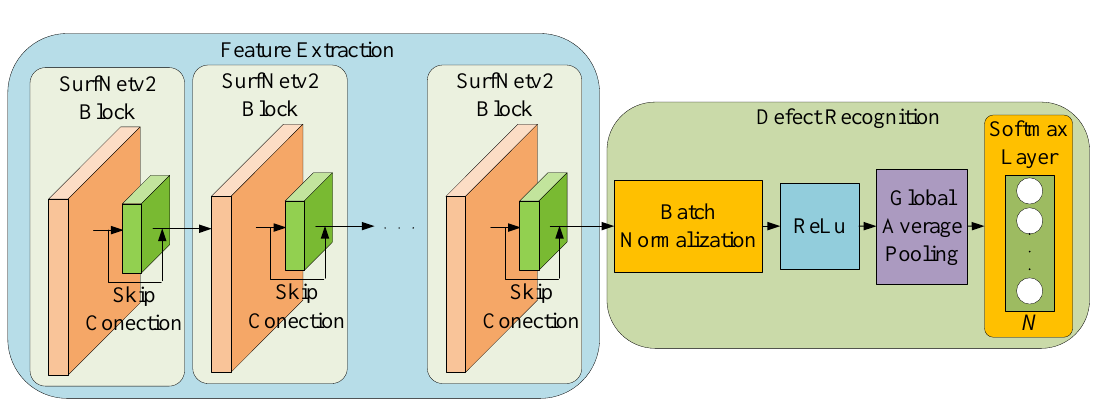
( b ) Figure 6. Comparison of ( a ) the original SurfNet block and ( b ) the proposed SurfNetv2 block.